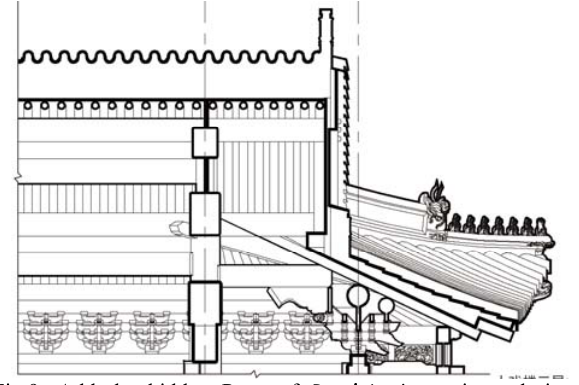
Fig.9. Add the hidden Parts of Daxi Lou 's section during